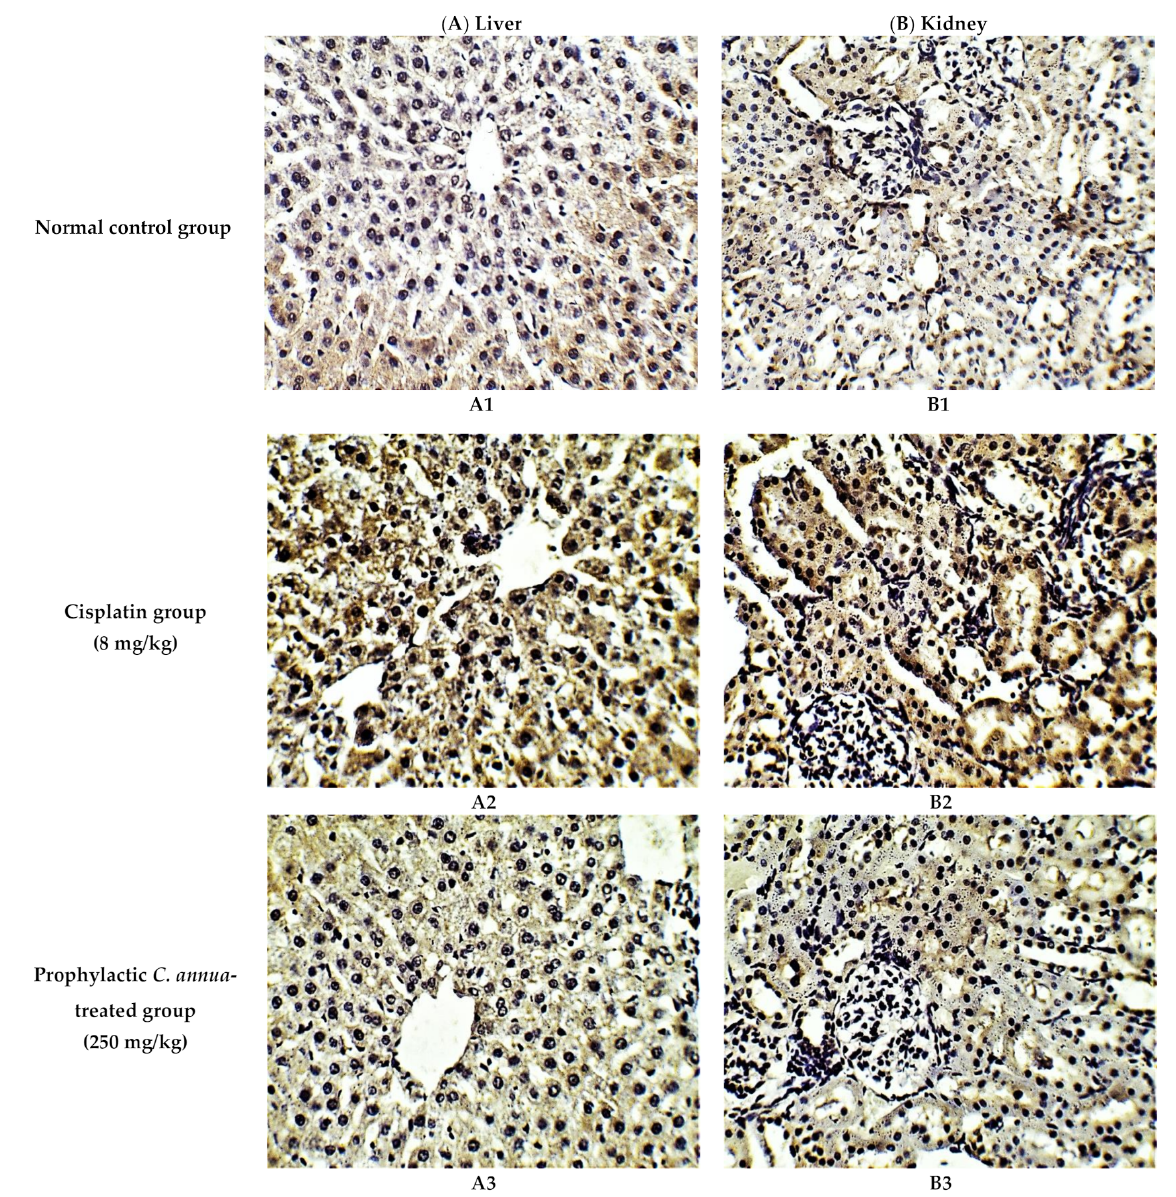
Figure 4. Representative photomicrographs ( × 400) of immuno-histochemical staining of caspase-3 in liver ( A ) and kidney ( B ) tissues of the experimental groups. ( A1 ) liver tissues of normal control group, ( A2 ) liver tissues of cisplatin group, ( A3 ) liver tissues of Prophylactic C. annua - treated group, ( B1 ) kidney tissues of normal control group, ( B2 ) kidney tissues of cisplatin group, ( B3 ) kidney tissues of Prophylactic C. annua - treated